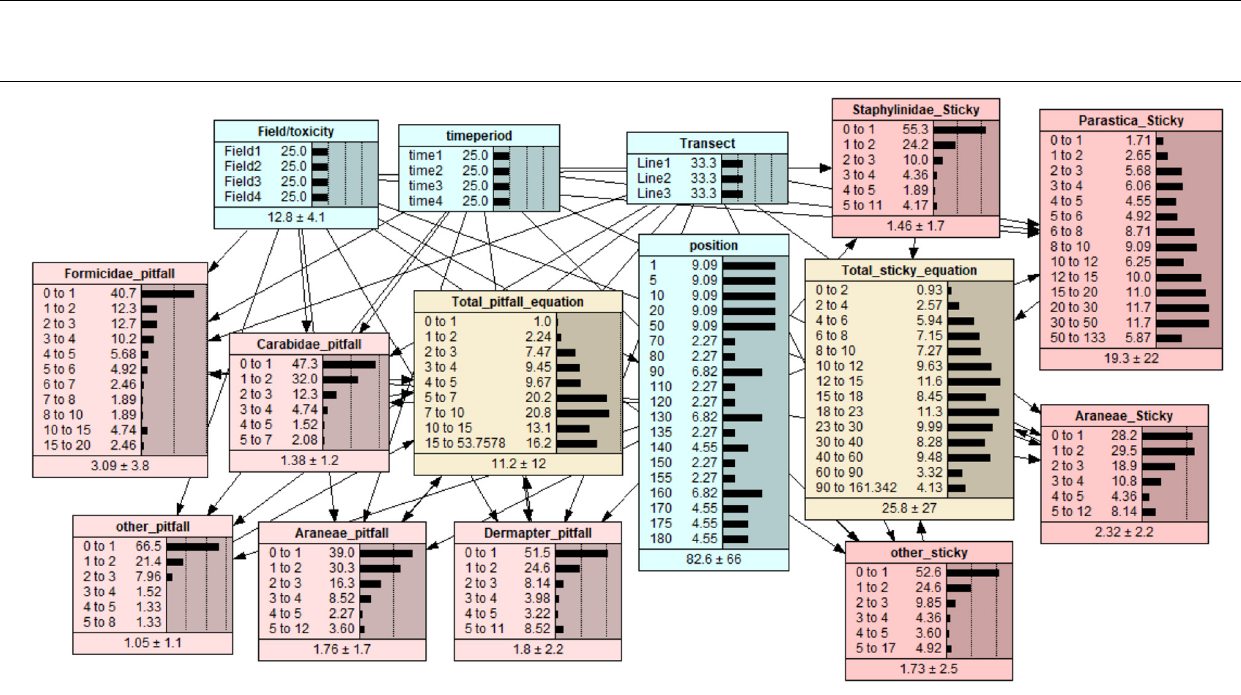
FIGURE 3 | A predictive Bayesian Network model for the overall data set which represents the interrelationships between the pesticide toxicity scores calculated for four brassica vegetable fields, sample position effects resulting from perennial woody vegetation at one field edge, transect number (3 per field) and sample date on the abundance of various natural enemy groups sampled by pitfall and sticky